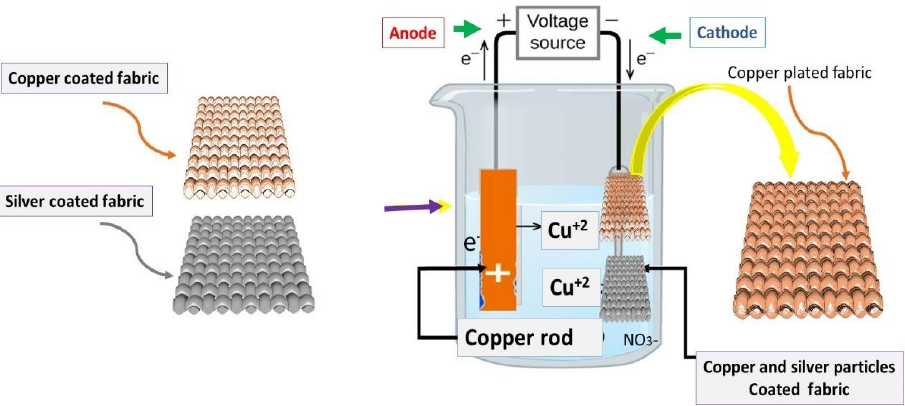
Figure 15. Schematic showing the electroplating of the copper by using copper electrode at cathode and conductive fabrics at anode .